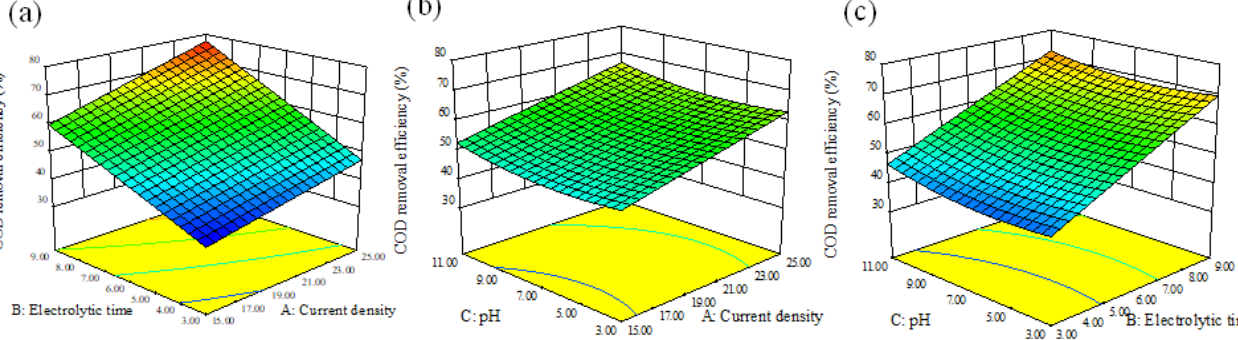
Figure 2. Normal probability plot of the internally studentized residuals for COD ( a ) and NH 3 − N ( b ) removal. Predicted versus actual values plot for COD ( c ) and NH 3 − N ( d ) removal.